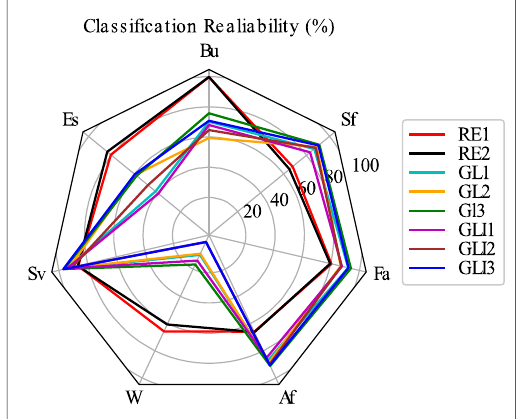
Figure 4. The multi-season SAR derived GLCM textures images had a high reliability (100 - commission error) to delineate vegetated land cover. Non-vegetated land cover were better classified by multi-spectral optical image (RE1,